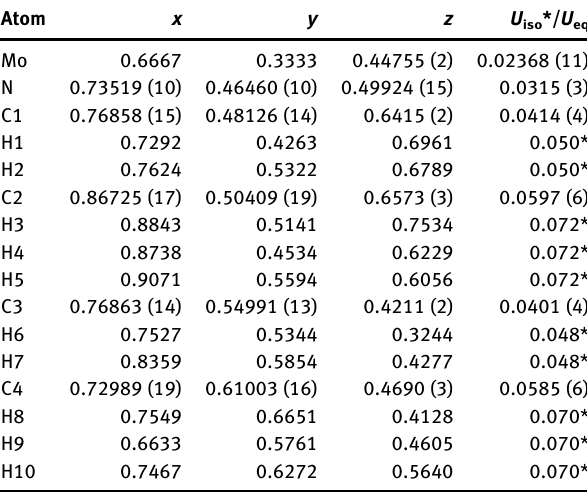
Table  : Fractional atomic coordinates and isotropic or equivalent isotropic displacement parameters (Å  ).